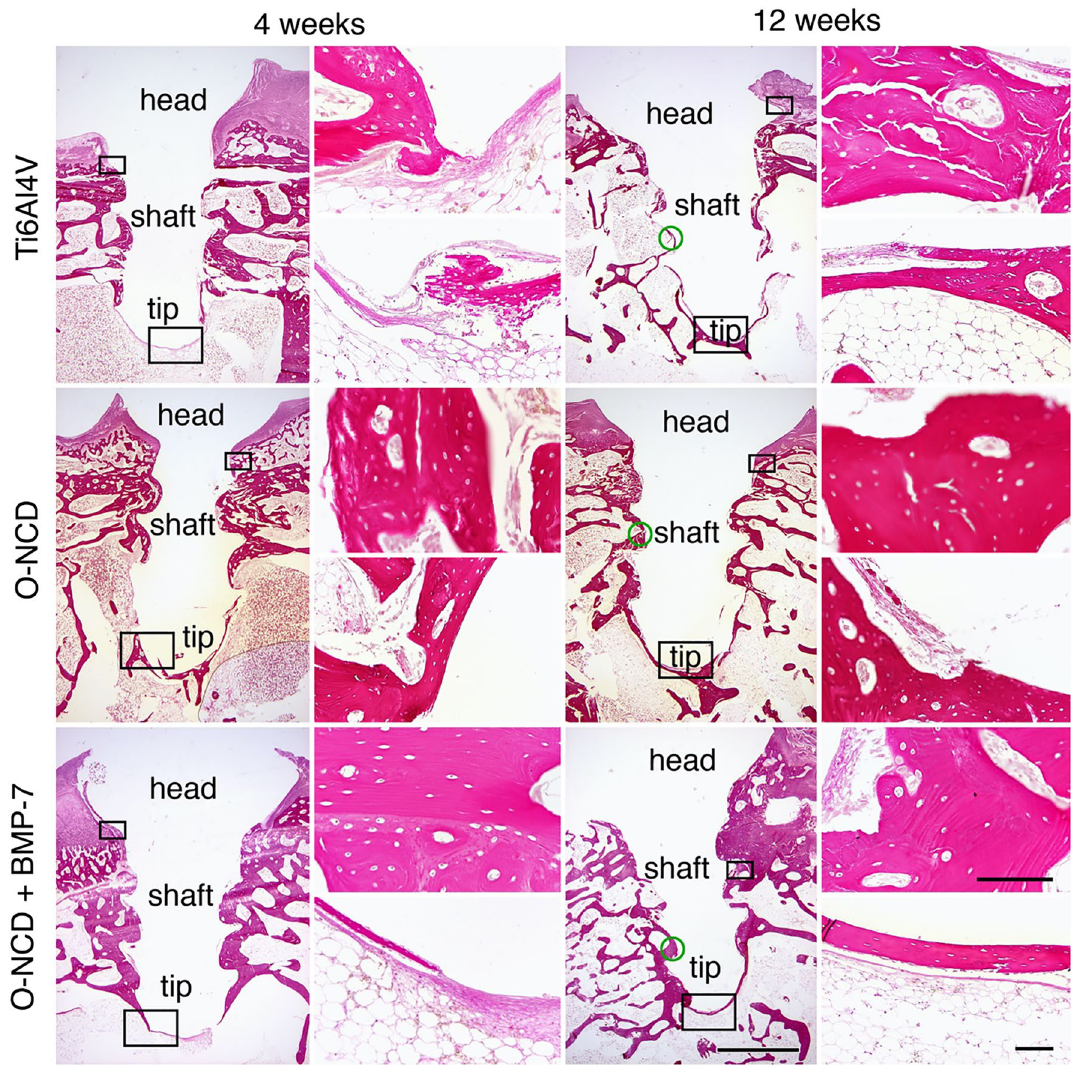
Figure 7. The histology of the implant site 4 and 12 weeks after the procedure. In contrast to bare metal implants, both coatings promoted bone formation at the screw tip at 4 weeks. Increased thickness of the newly- formed bone is evident in the O-NCD-coated group with a further increase in the O-NCD + BMP-7-coated group in both time intervals, confirming the micro-CT data (Fig. 6). The panel on the left shows the whole implant in elastin staining at low magnification, and the panel on the right shows higher power views from the region of the head and the tip (hematoxylin–eosin staining). Empty spaces correspond to fat cells in the bone marrow. Boxes indicate the approximate position of the high-power views taken on the sister sections. Green circles indicate points of measurements for quantification. Scale bars 1 mm (overview images), 100 µm (high power